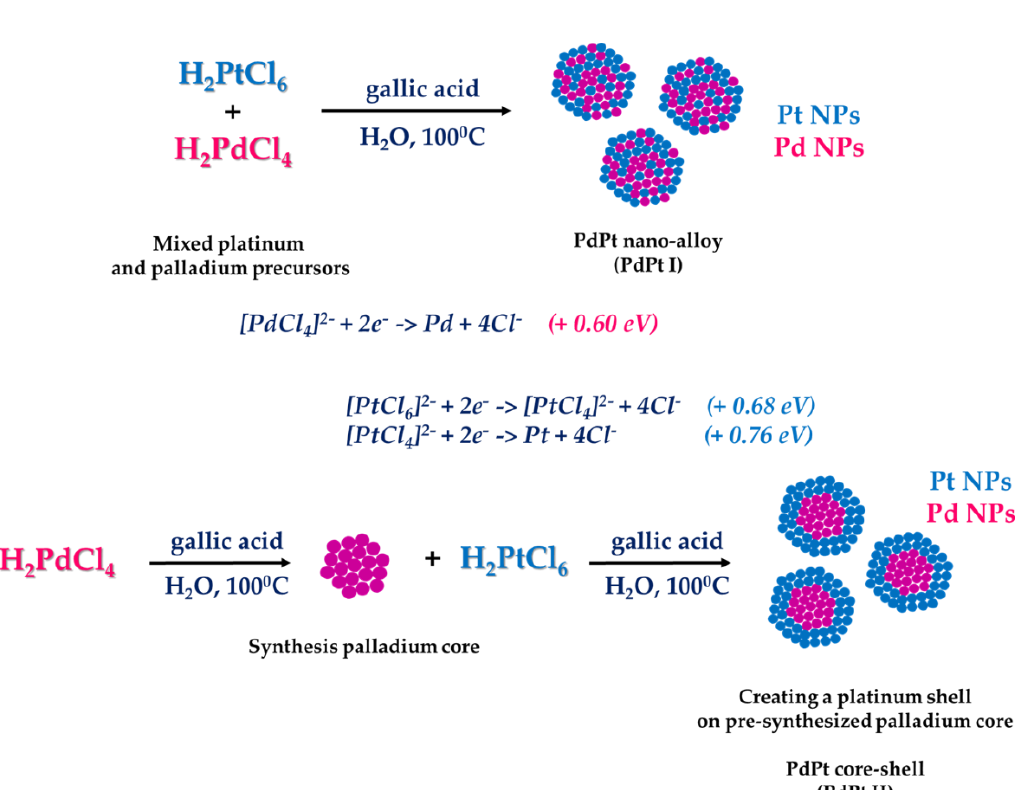
Figure 2. Green synthesis mechanism of: ( A ) PdPt nano-alloy and ( B ) PdPt core-shell NPs, considering the electrochemical potentials of individual reactions.